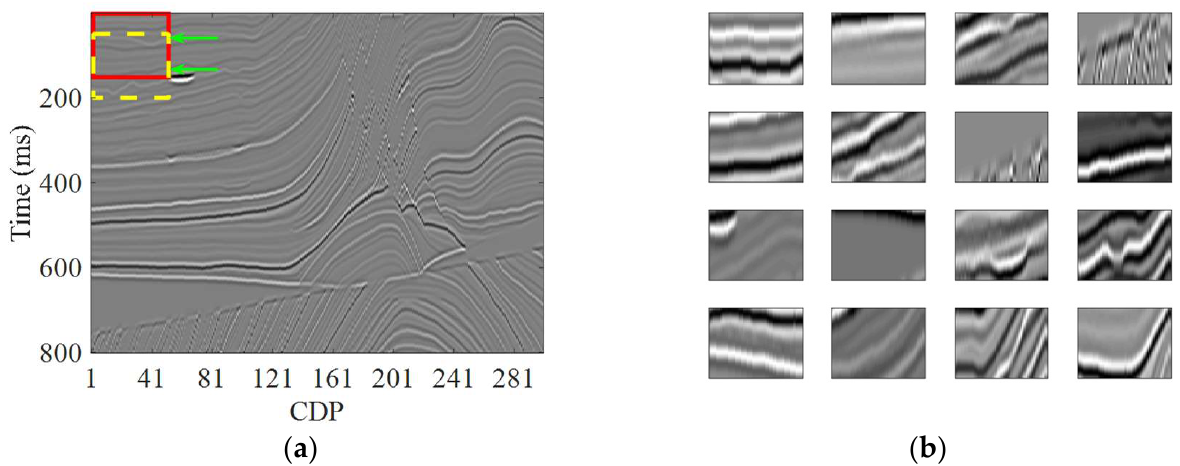
Figure 2. ( a ) Synthetic poststack seismic data and ( b ) some seismic patches decomposed from the seismic profile with a sliding window.